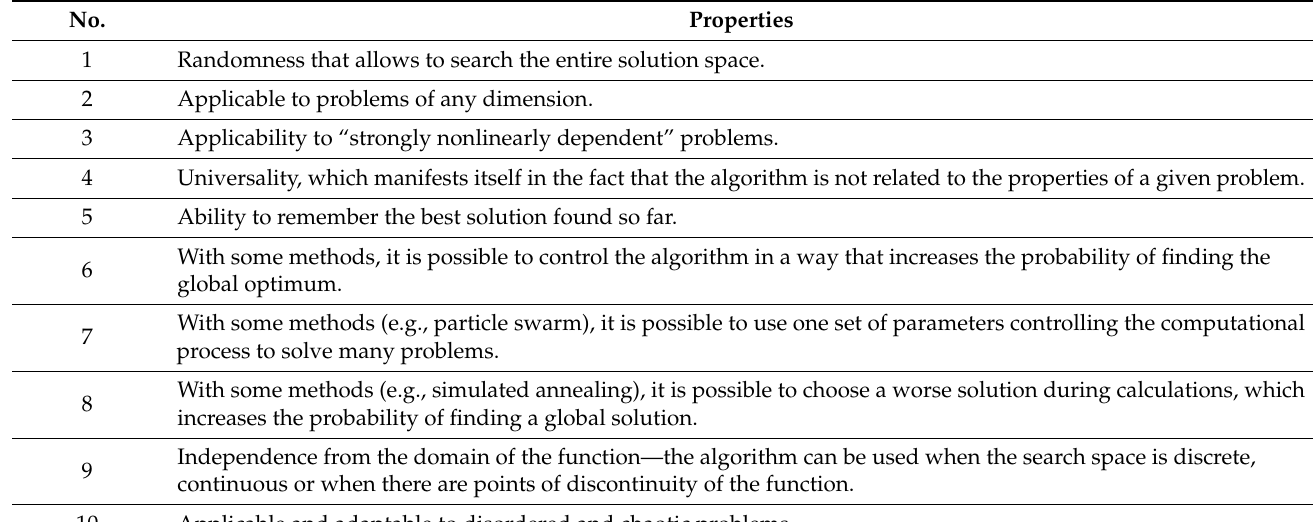
Table 2. The most important properties of heuristic methods